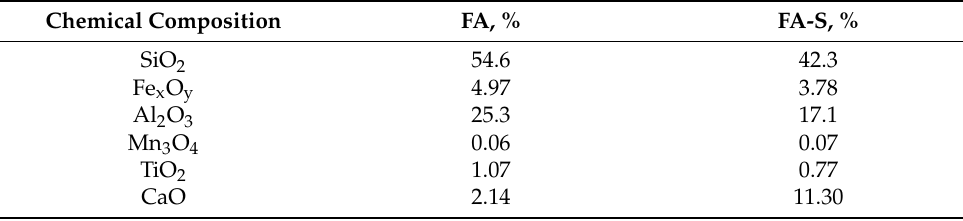
Table 1. The chemical composition of fly ash (FA) and ash–slag (FA-S). Chemical